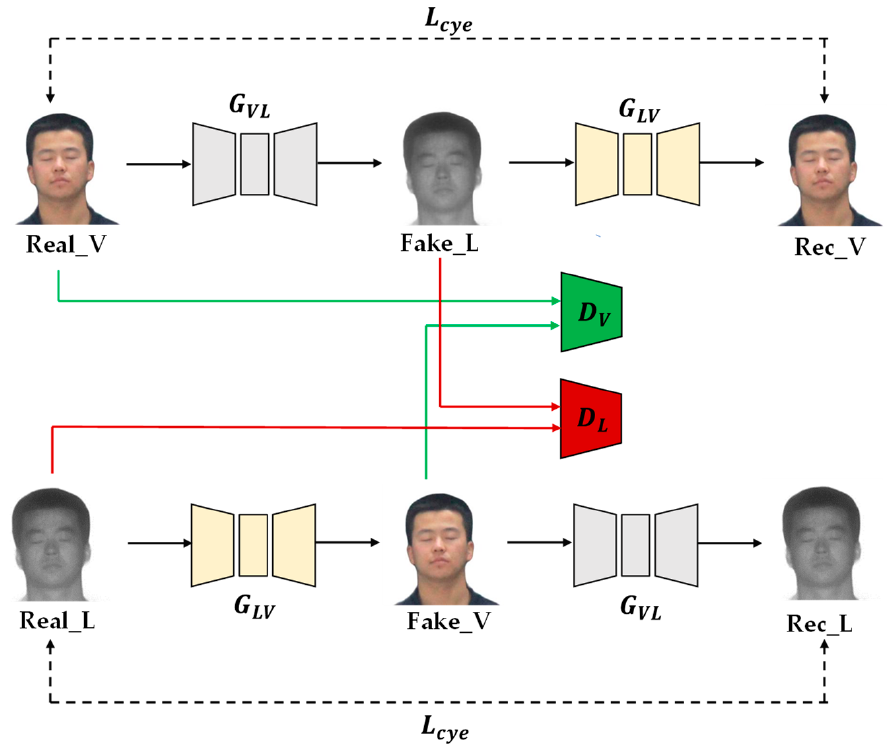
Figure 3. Structure of CycleGAN model.